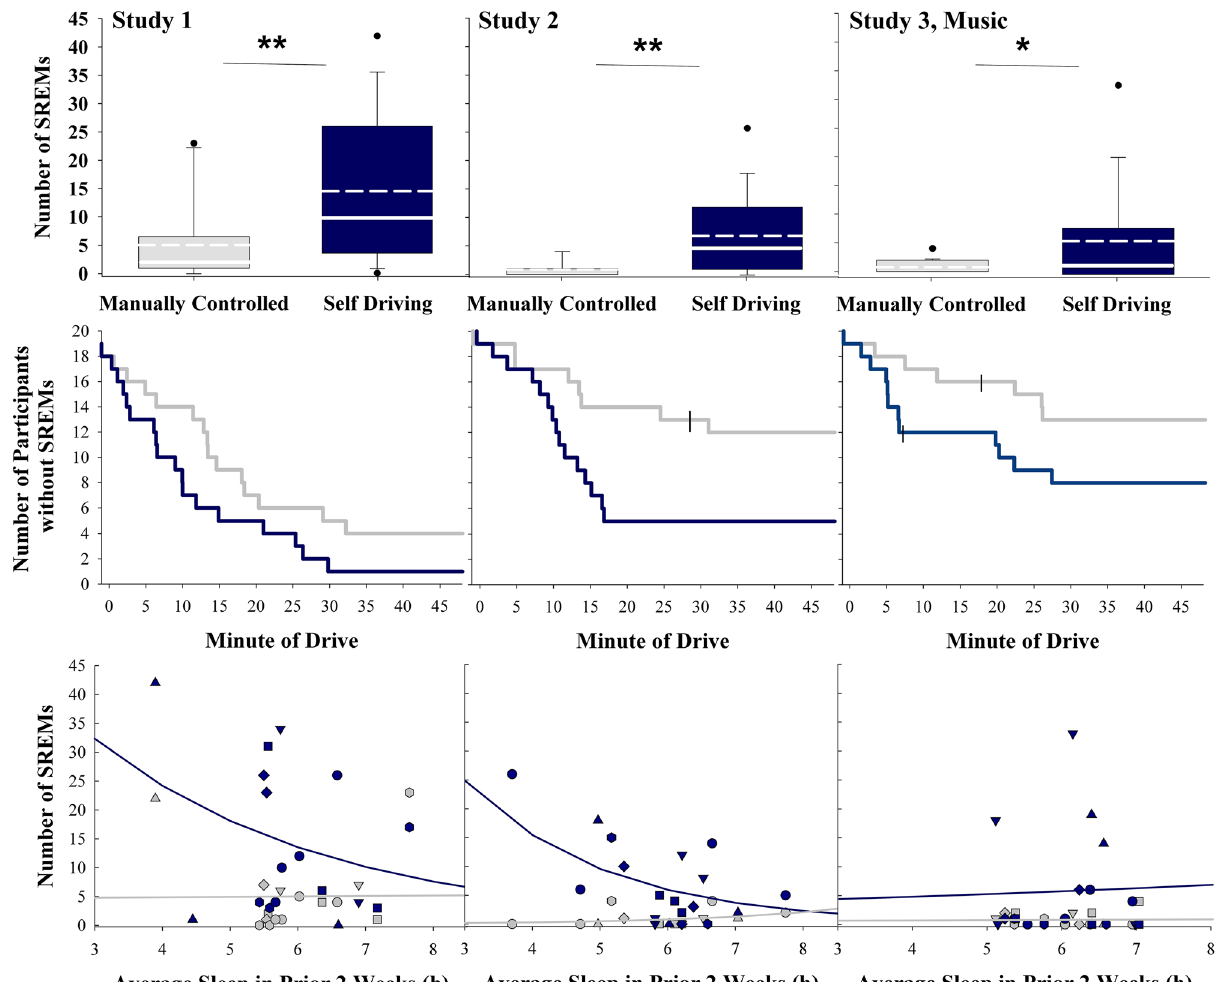
Figure 1. Slow rolling eye movement (SREM) characteristics during the manually controlled and self-driving conditions for each study. A greater number of SREMs indicates higher sleepiness. Top row = number of SREMs by condition and study. For each box, the solid white line indicates the median, the dashed white line indicates the mean, and the bottom and top boundaries of the box indicate the 25th and 75th percentiles, respectively. The bottom and top whiskers indicate the 10th and 90th percentiles, respectively (Study 1 n = 17; Study 2 n = 19; Study 3 n = 18). Middle row = Survival plots showing time to first SREM by condition and study. Blue = self- driving, gray = manually controlled, hatched lines indicate the time that individual participants were censored due to premature termination of the drive (Study 1 n = 19; Study 2 n = 20; Study 3 n = 20). Bottom row = Number of SREMs plotted by sleep duration in the prior two weeks by condition and study. Fit lines represent the negative binomial regression. Blue = self-driving, gray = manually controlled (Study 1 n = 17; Study 2 n = 19; Study 3 n = 18). * = p < 0.05; ** = p <